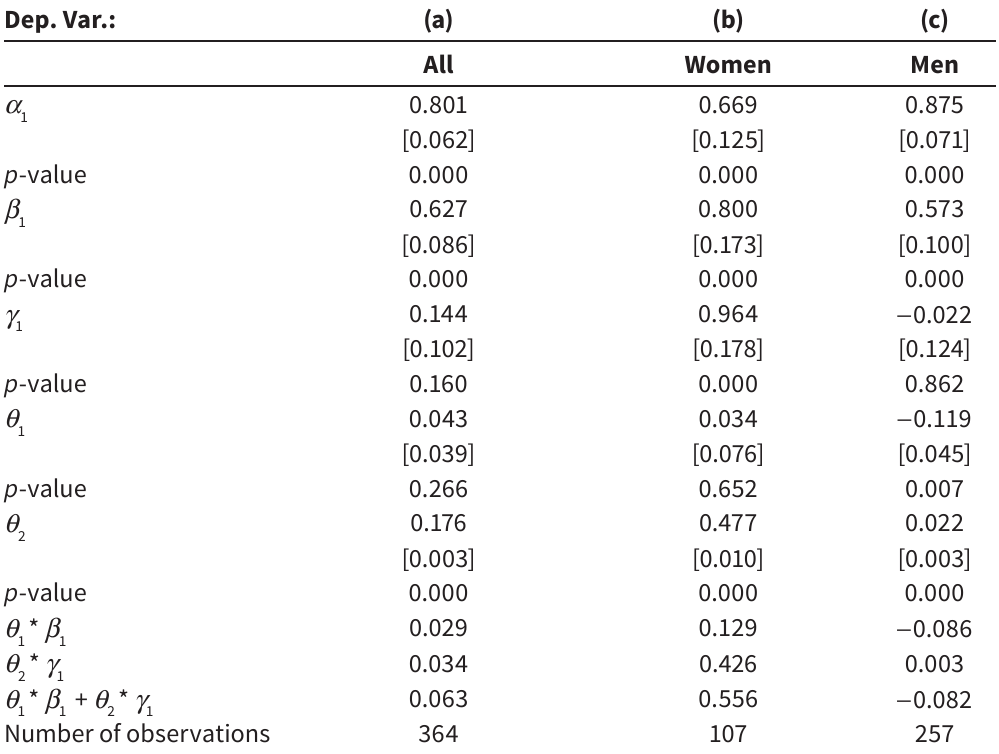
Structural Equation Model